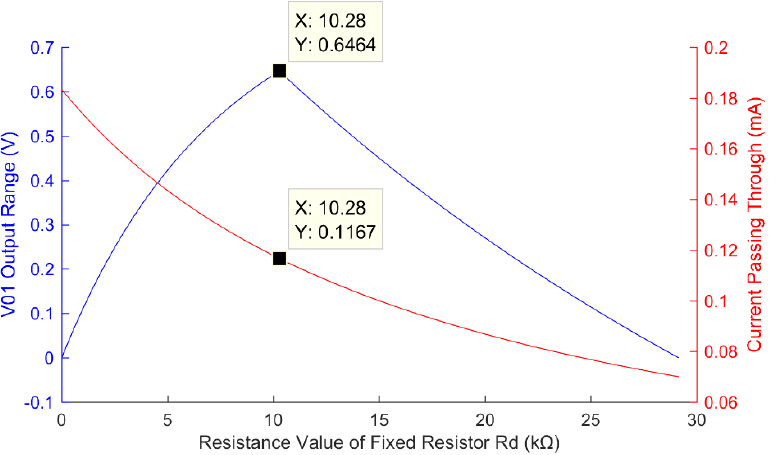
Figure 4. Relationship between the output range (the blue line) and current loss (the red line) of the fixed resistor grounding bleeder circuit and the resistance value of the fixed resistor.